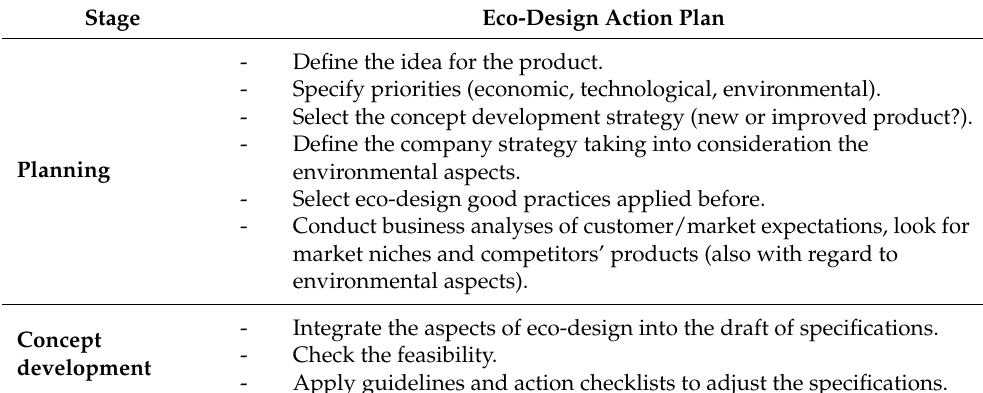
Table 1. The process of eco-design—product development and related actions (own work based on